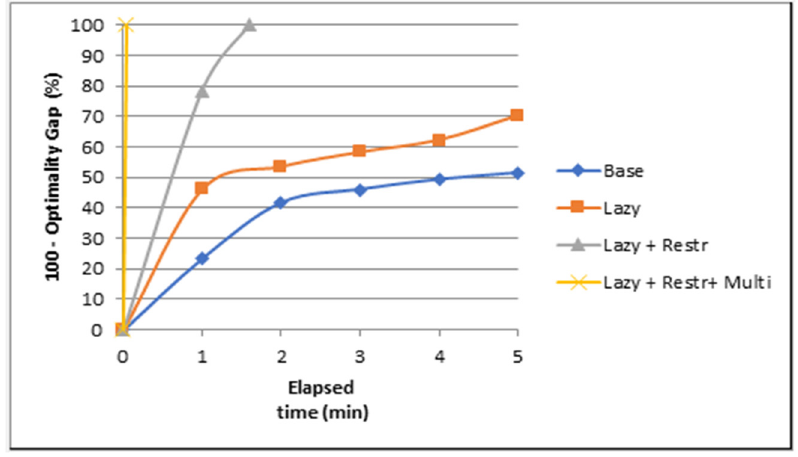
Figure 8. Comparison of optimality gaps for first five minutes of running. Table 17. Outcomes of the instance with different approaches.